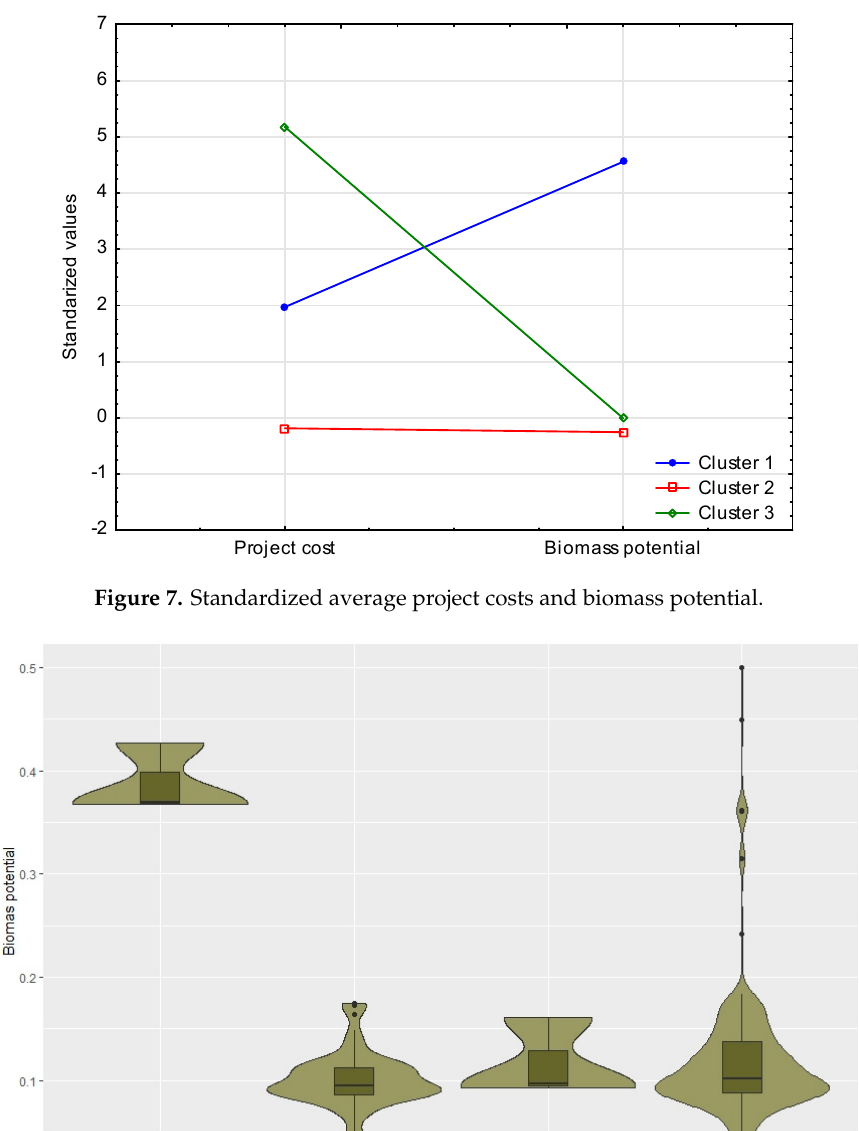
Table 4. Descriptive statistics for biomass energy clusters.